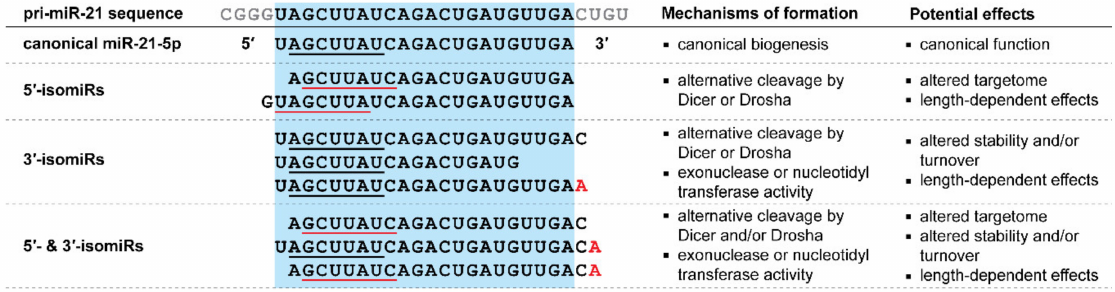
Figure 2. Di ff erent types of isomiRs, their mechanism of formation and their potential functional e ff ects. The sequence of miR-21 and some of its isomiRs are shown to exemplify the di ff erent isomiR types. In each case, the seed sequence is underlined (red if altered) and red nucleotides are due to nucleotidyl transferase activity. Relative to the canonical microRNA, 5 (cid:48) -isomiRs generally have an altered targetome due to shift in seed sequence whereas 3 (cid:48) -isomiRs can a ff ect the microRNAs stability or turnover. Both types of isomiRs a ff ect the length of the microRNA and can thus incur length-dependent e ff